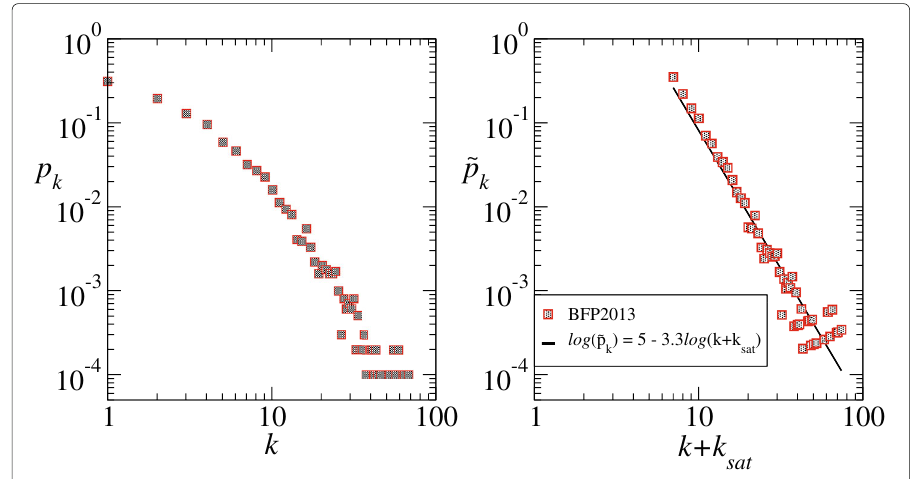
Fig. 3 Degree distribution p k for the federal criminal intelligence network in log-log axis, showing the typical real networks features of low degree saturation and high degree cutoff (left panel). Re-scaled degree function ˜ p = p ( k / k ) as a function of ˜ k = k + k cut sat in log-log scale and the power-law fit (right panel). The k k exp